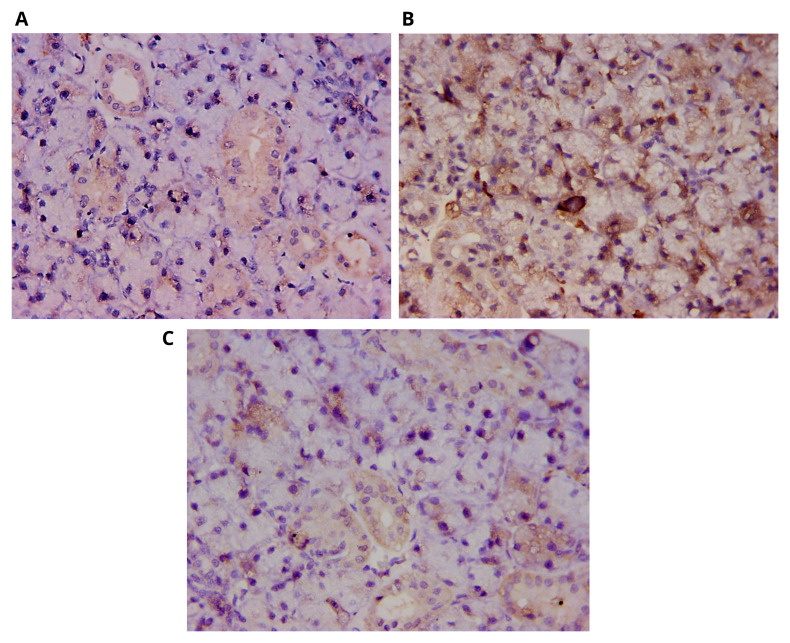
Photomicrographs showing Ki-67 immunoreactivity.(
A) Control group, positive reaction to Ki-67 protein in the secretory acini and the wall of the blood vessels; (
B) DXR group, increased reactivity of Ki-67 in the secretory acini together with the nuclear and perinuclear reactivities; (
C) DXR+EGF group, decreased Ki-67 immunoreactivity in the acini. DAB, orig. mag. X400.